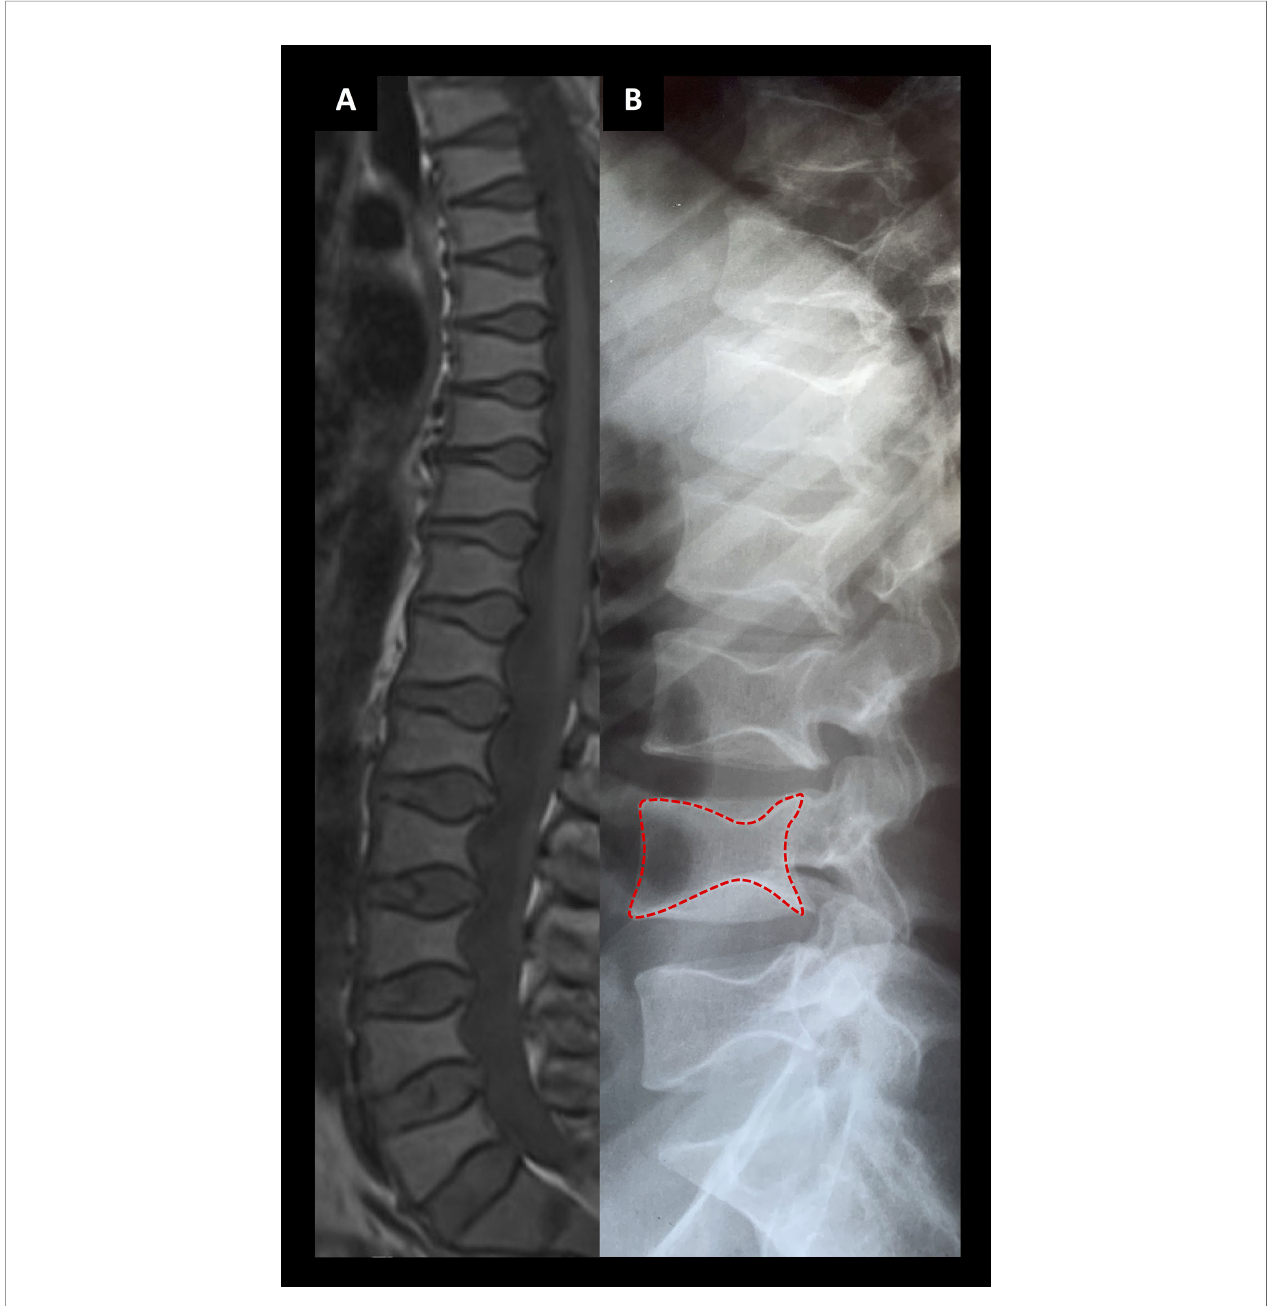
FIGURE 3 | Spinal images of two patients associated with a novel TBX2 missense variant p.Thr300Met. (A) An MRI section of the female index at age 24 years and (B) a lumbar radiograph of her father at age 24 years showing cod fi sh-type vertebral dysplasia with balloon-shaped intervertebral